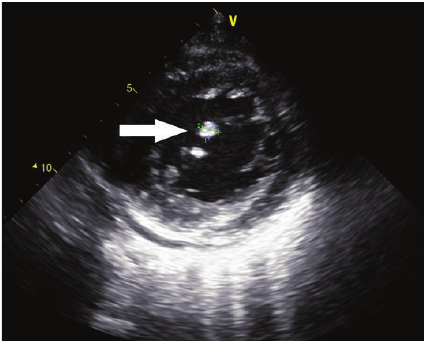
Figure 1: Echocardiography of the patient’s showed vegetation on the mitral valve leaflet ( 7.67 mm ∗ 6.14 mm), mitral valve prolapse and moderate regurgitation, mild degree backstreaming of tricuspid valve, and left ventricular enlargement.